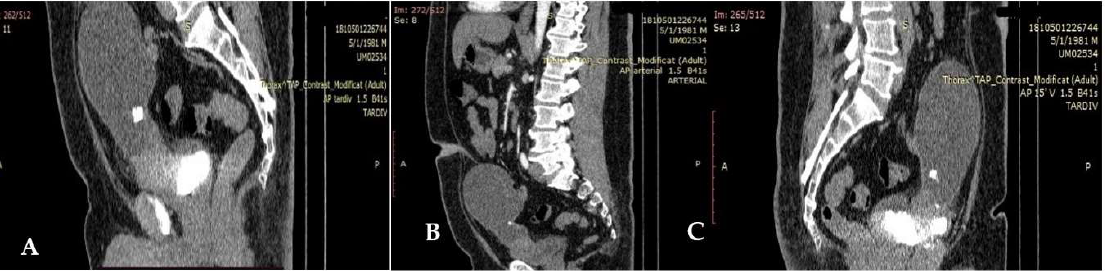
Figure 1. ( A – C ) Heterogeneous, hypodense mass develop partly in the bladder ( A , B ); infiltration of the surrounding tissue ( C ). the surrounding tissue ( C